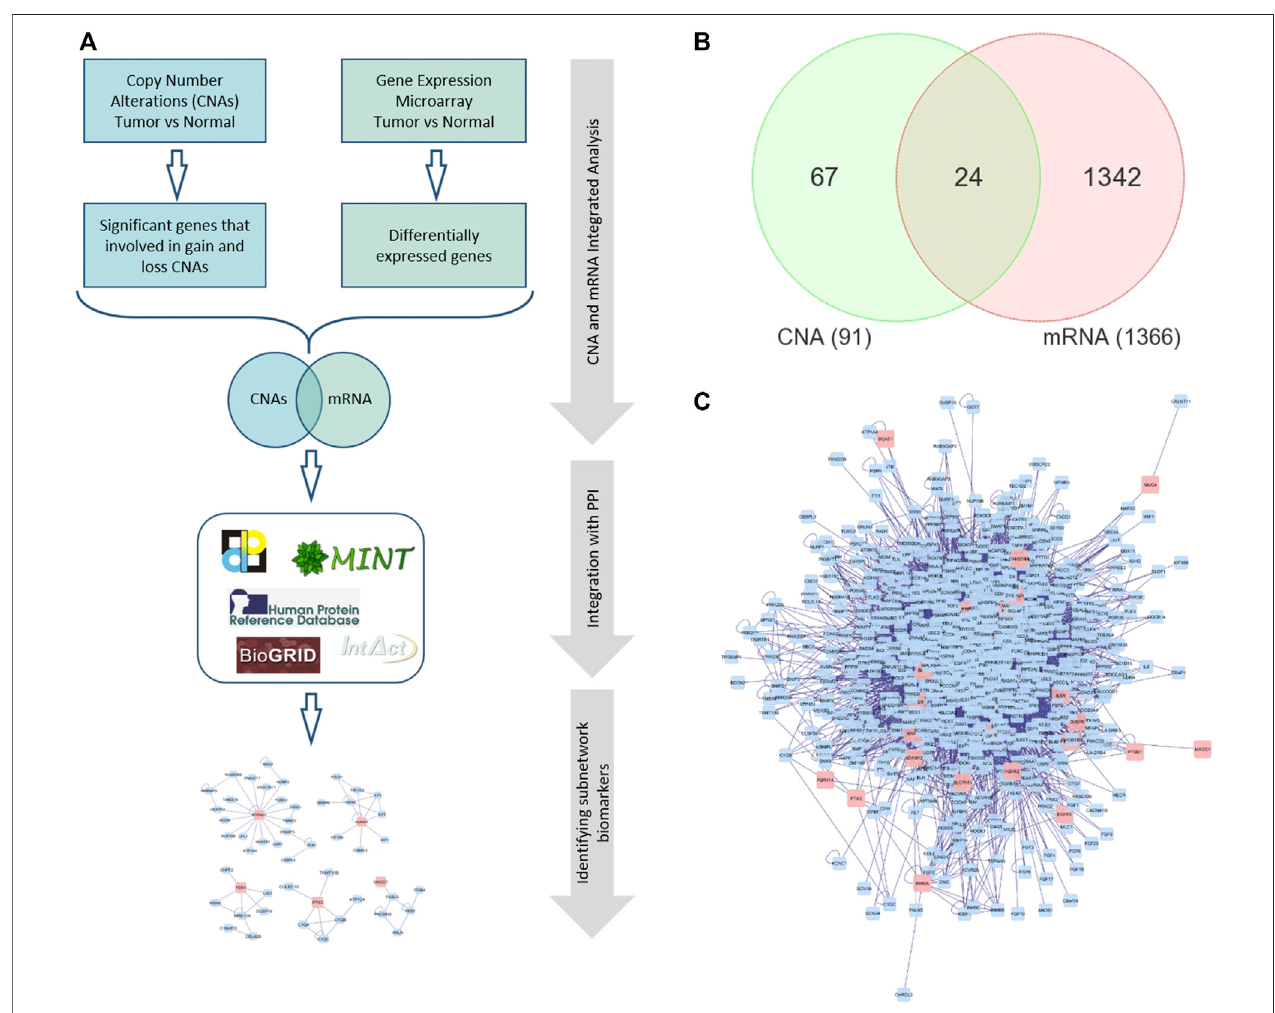
FIGURE1 | (A) The framework ofperforming integrated omicsand network-based analysis. (B) Venn diagram representing the overlapping DEGs between global mRNA and CNA. (C) A PPI network for the seed/differentially expressed genes. Red nodes indicate the seed genes and the blue ones are the interacting genes. Edges represent the interactions. PPI: Protein-protein